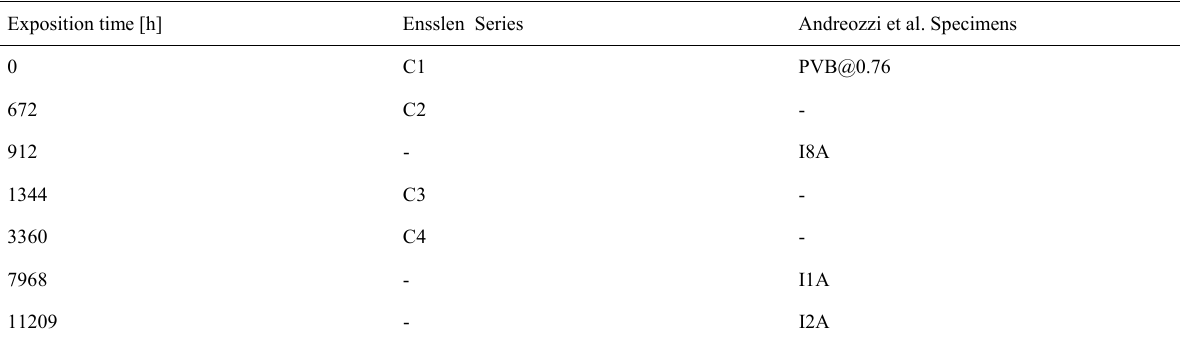
Table 1. Exposition times for the specimens of Ensslen (2007) and of Andreozzi et al.